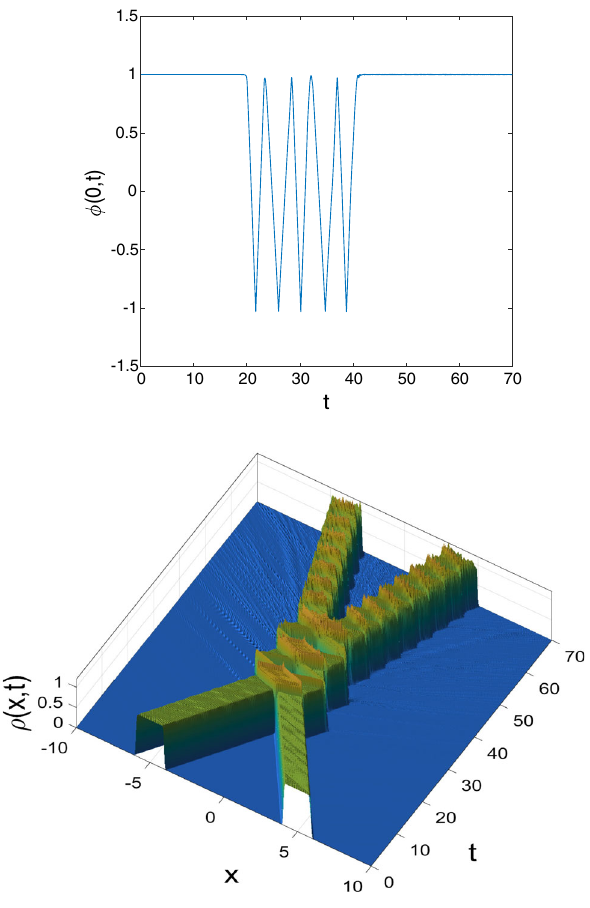
Fig. 7 Illustration of a 5-bounce solution for n = 16